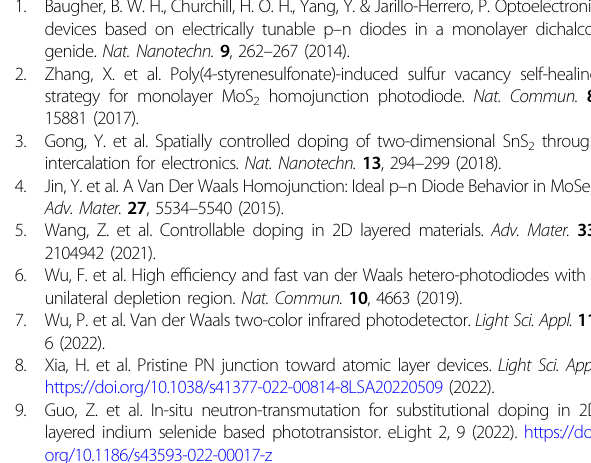
choose 2D InSe as the host material. NTD could be cation. After thermal neutrons irradiation on 2D InSe, the main nuclear reaction occurs in the indium atoms, as shown in Fig. 1a. The transmutation reaction is displayed by 115 In ð n ; γ Þ 116 In ! 116 Sn ( β - decay). The 115 In isotope 49 49 50